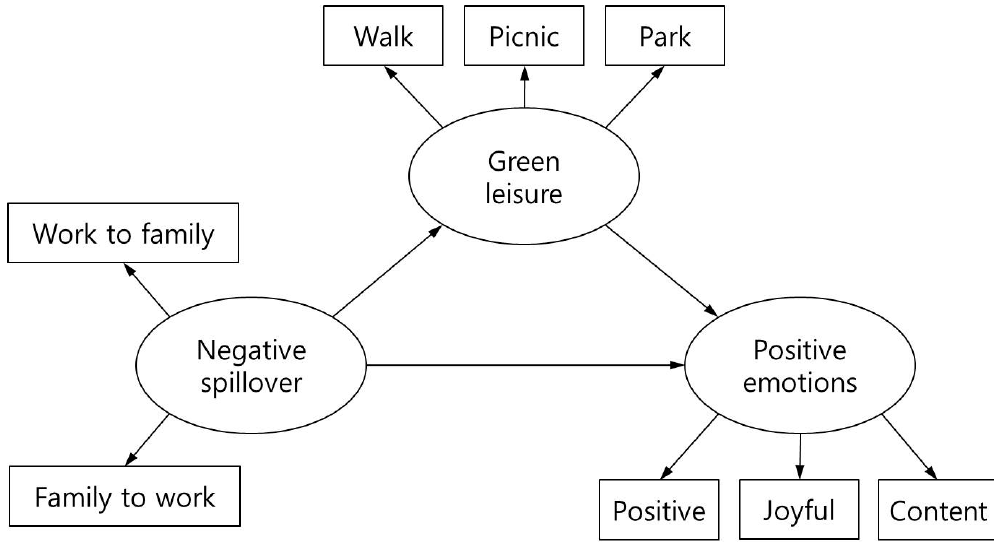
Figure 1. Tested conceptual model.